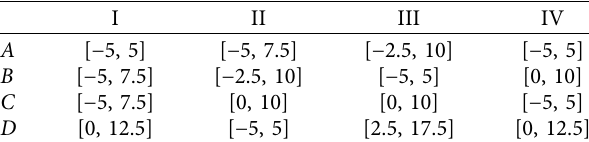
Table 9: Subtraction of the minimum interval in each column.